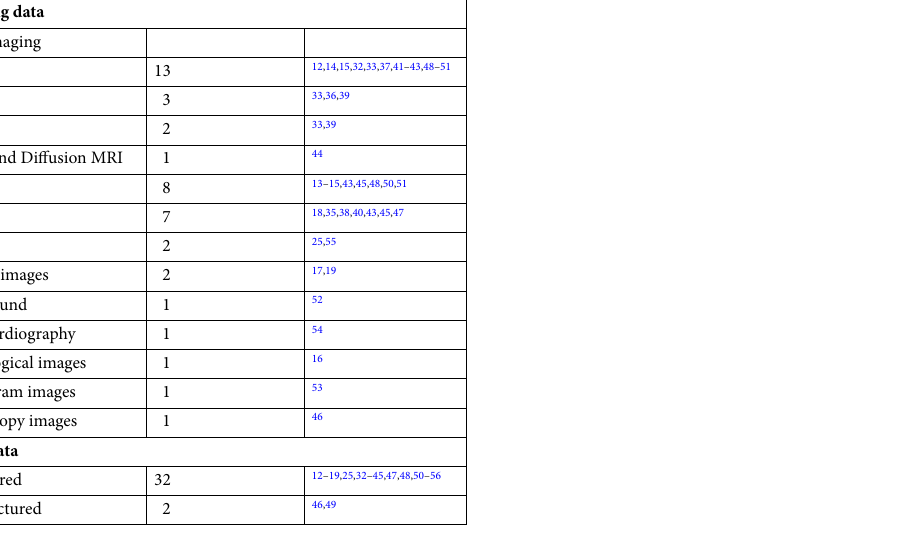
Table 4. Patient data types used in the included studies.